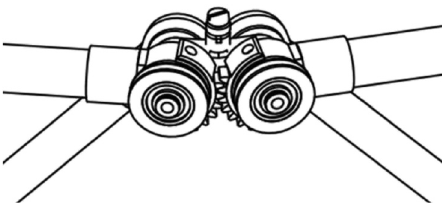
Figure 3: Hinge unit with the deployment synchronizer.